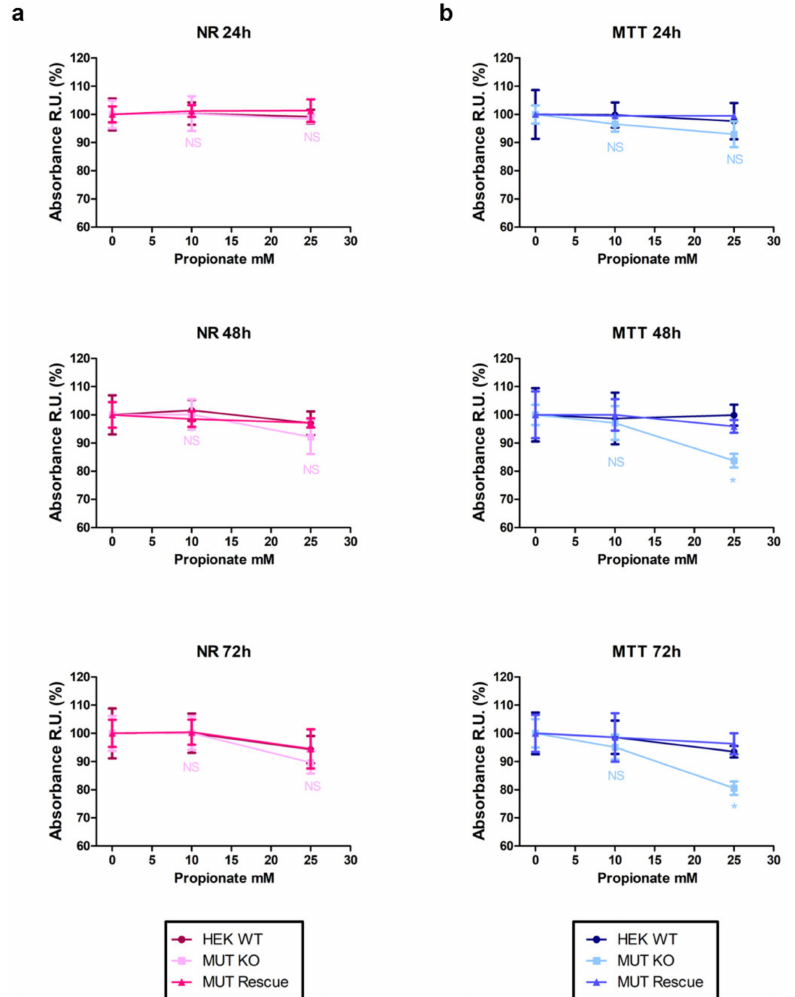
Figure9. Cellviabilityassaysinapropionate-enrichedculturemedium. WT,MUT-KO,andMUT-Rescue cells were kept in culture in a propionate-enriched medium and analyzed by ( a ) NR and ( b ) MTT assays. The analyses were performed in three independent biological replicates. Absorbance values for each cell type were expressed as fold change (relative units, RU) with respect to the values of the corresponding non-treated (0 h time point) cell type. Data were reported as mean values of the three experimental replicates ± SD. A one-way two-tail paired t -test was used to calculate the statistical significance of di ff erences between the three tested cell types. * p < 0.05; NS: Not significant ( p >